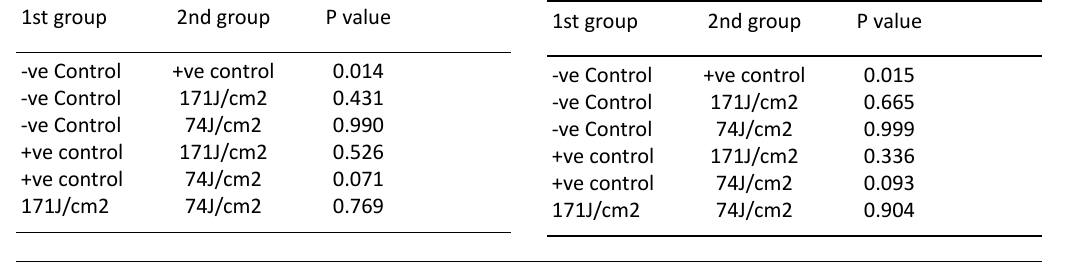
Table 12. Head circumferences comparison in day four between every pairs 1st group